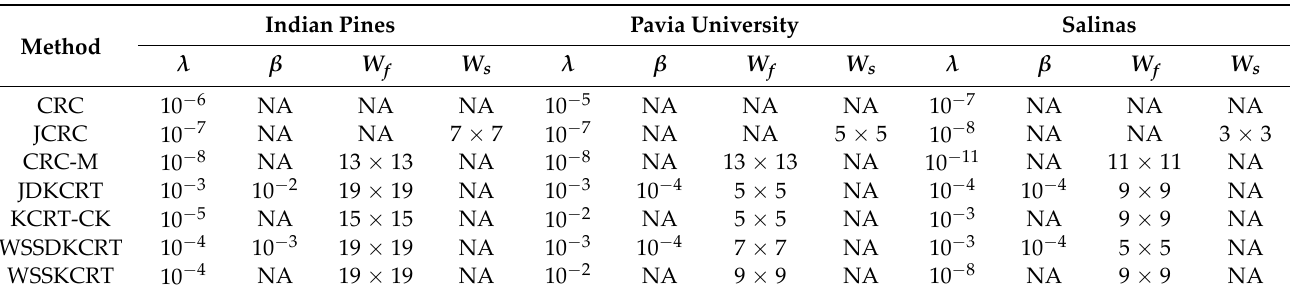
Table 2. Optimal parameter settings for the compared methods on the Indian Pines, Pavia University, and Salinas scenes.